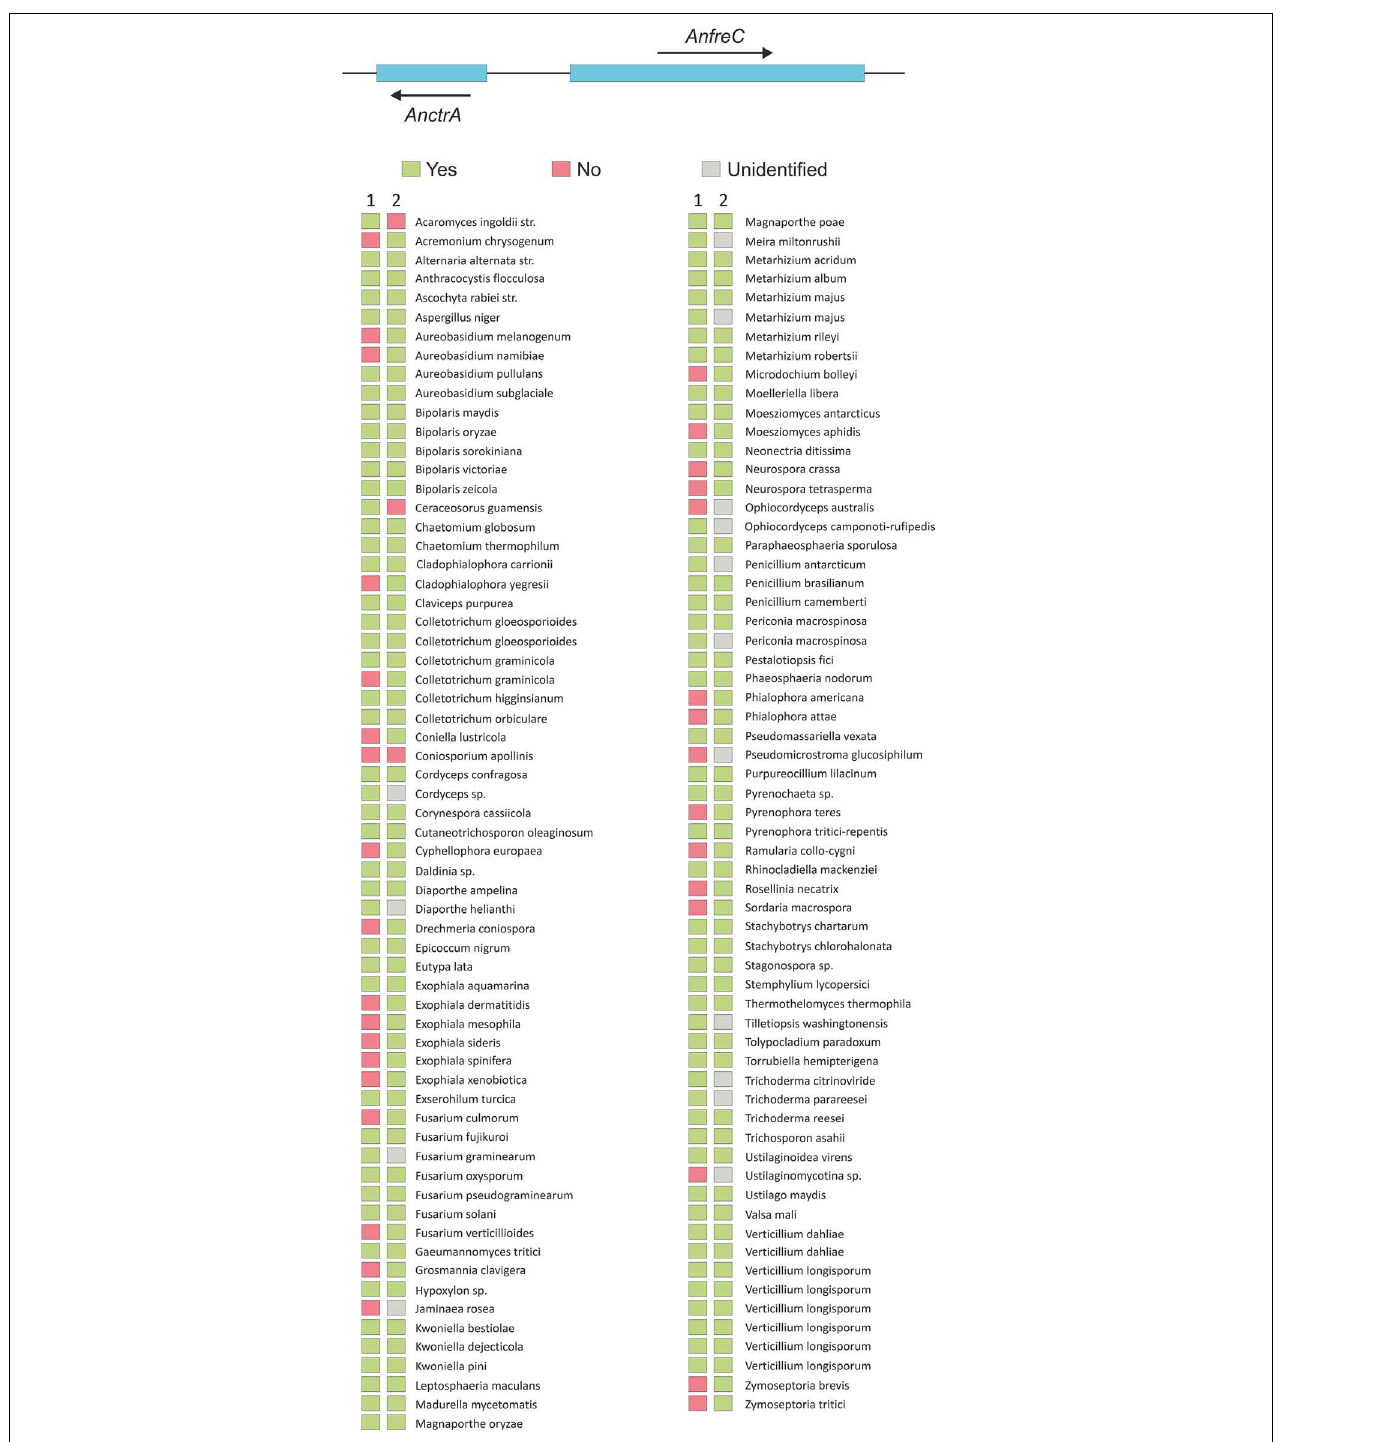
FIGURE 8 | An image representing the chromosomal location of AnfreC - AnctrA , and a list of fungal organisms that possess an AnctrA ortholog are presented. (1) The organism possesses another Ctr protein ortholog of AnctrC . (2) The organism possesses an Ox-Red coding gene beside the AnctrA ortholog, just like A. nidulans . The color of the rectangles next to the organism represents: green (yes), red (no) and gray (unidentified).